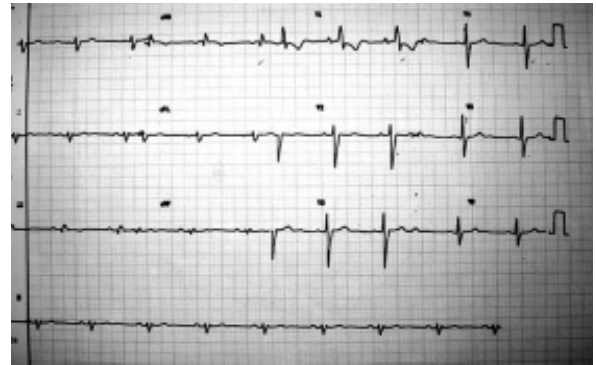
Fig. 4 - Eletrocardiograma de paciente com melanoma de VD. Notar a inespecificidade das alterações: ritmo sinusal; PR=0,16 ms; eixo QRS=30º; alterações inespecíficas da repolarização ventricular em parede anterior (“R” amplo e “T” negativa em V1)